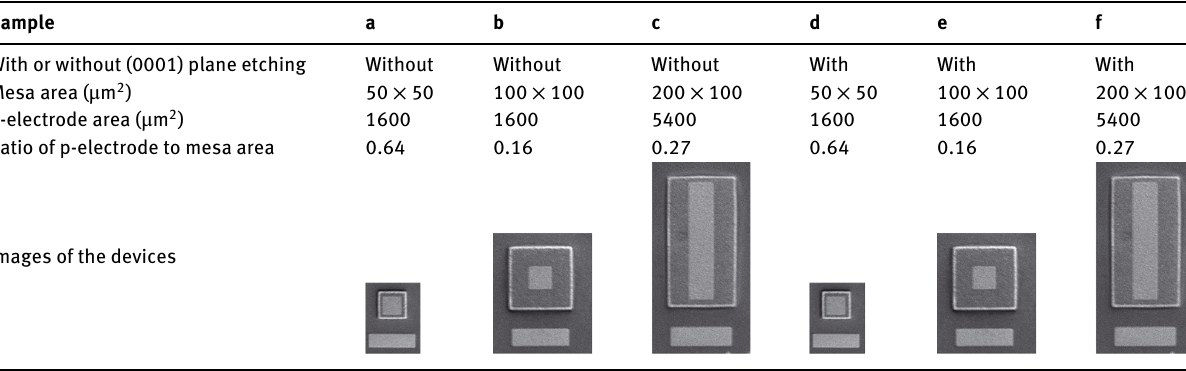
Table 1: NW-LED samples with/without dry etching of (0001) plane area and the corresponding device size.